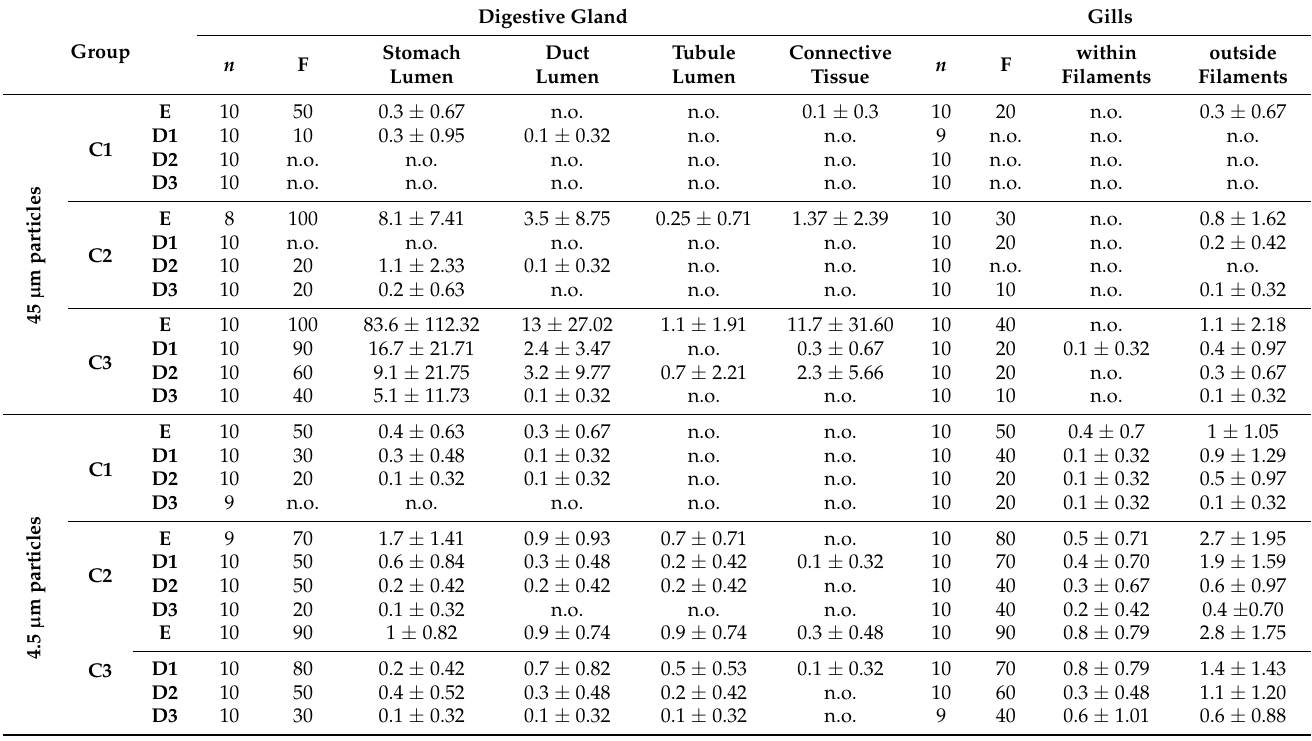
Table 1. Prevalence of mussels presenting MPs and abundance of particles found in the different structures of the digestive gland and in the gills. Data are expressed as mean ± standard